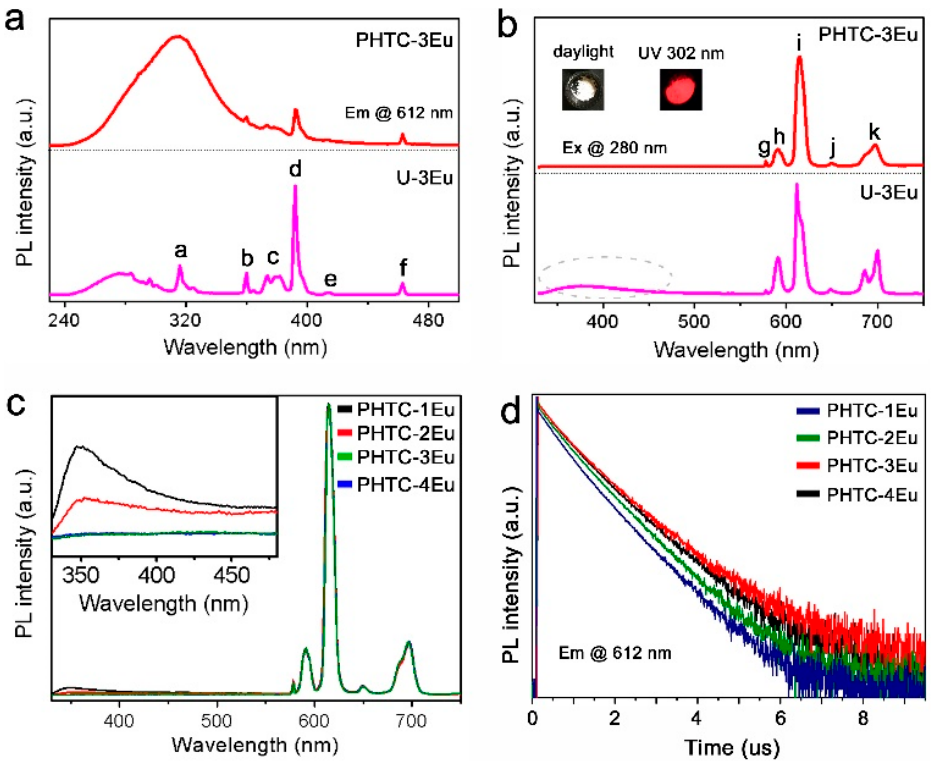
Figure 4. ( a ) Normalized excitation ( λ em = 612 nm) and ( b ) emission spectra ( λ ex = 280 nm) of PHTF- 3Eu and U-3Eu. Insert: photos of PHTF-3Eu under daylight and a 302 nm UV lamp. ( c ) Normalized emission spectra of PHTF:Eu excited at 280 nm, Insert: enlarged emission spectra of PHTF:Eu sam- ples in the range of 330 to 480 nm. ( d ) PL decay curves of PHTF:Eu excited at 280 nm.